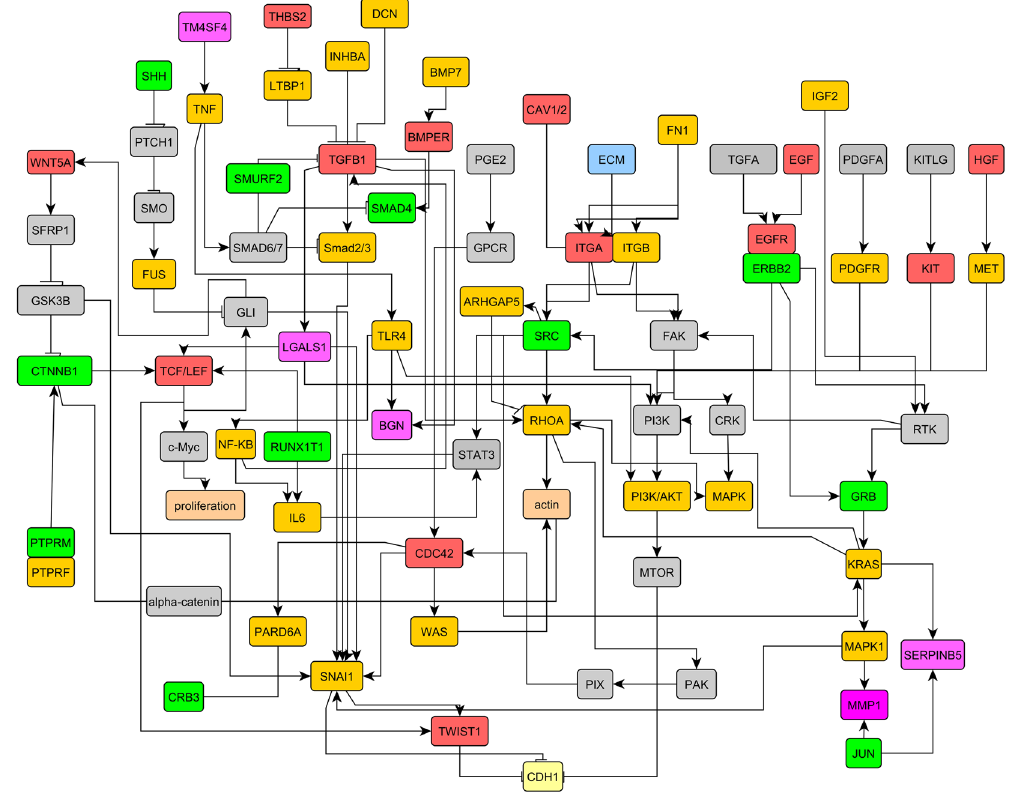
Figure 6. The interaction network of cancer cells and their microenvironment associated with the EMT process. Genes mapped on the network were obtained from differentially expressed genes in the tumor buds and the microenvironment. The image was drawn with yEd graph editor (http://www.yworks.com/en/products/ yfiles/yed/).